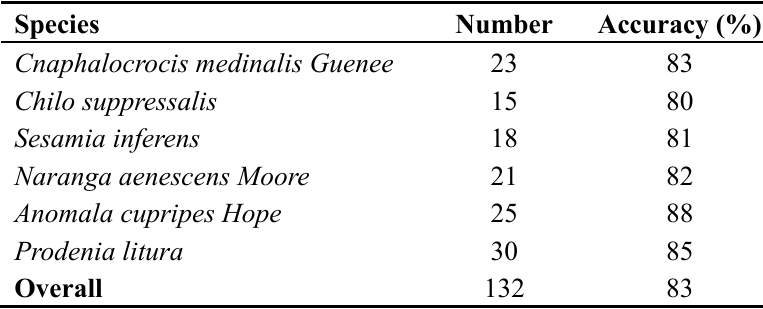
Table 2. Testing results for